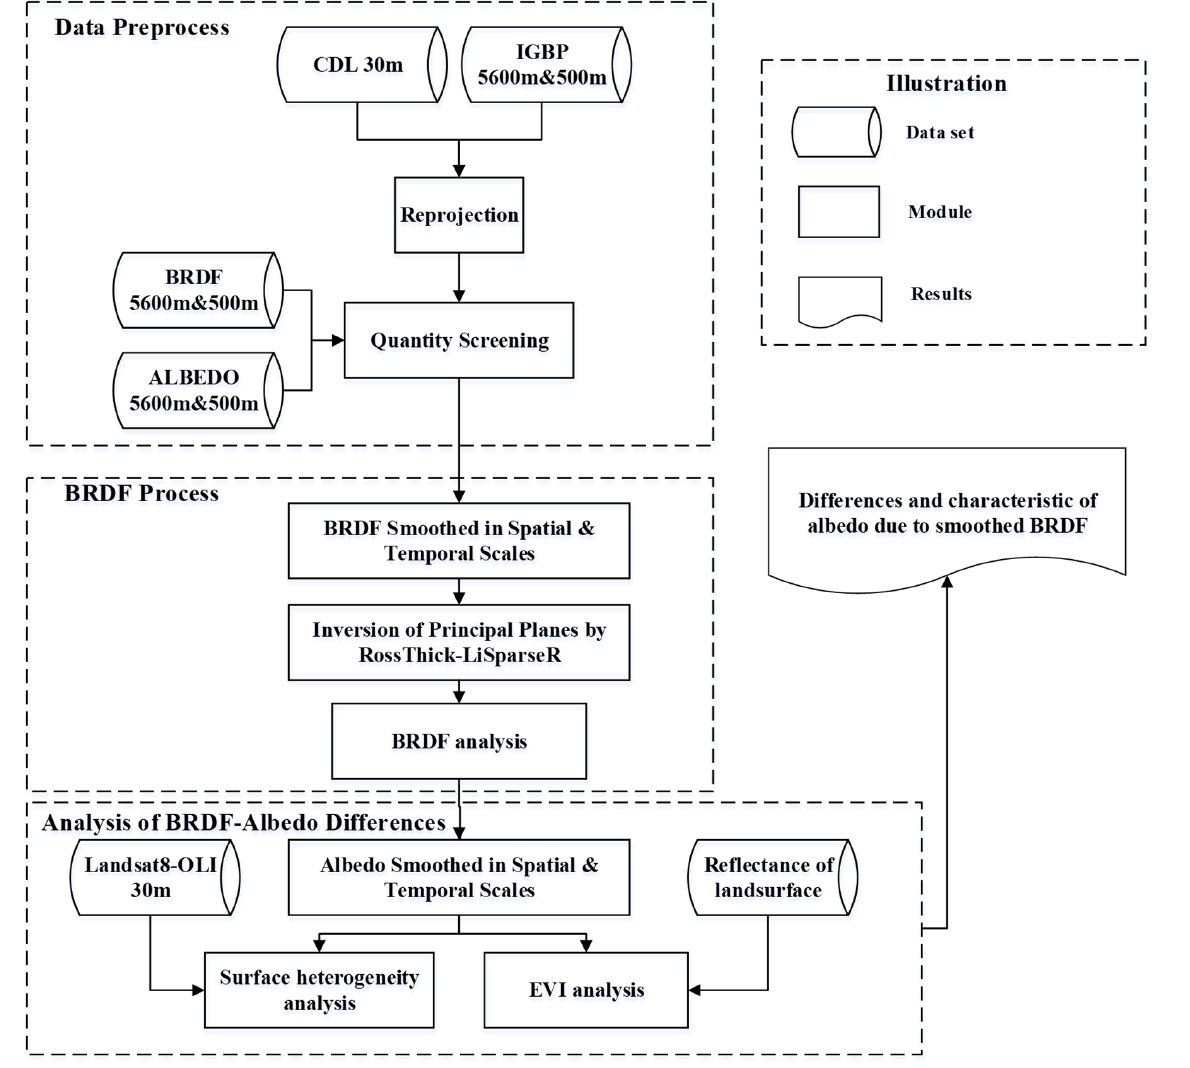
Figure 4. The Work flow chart. Figure 4. The Workflow